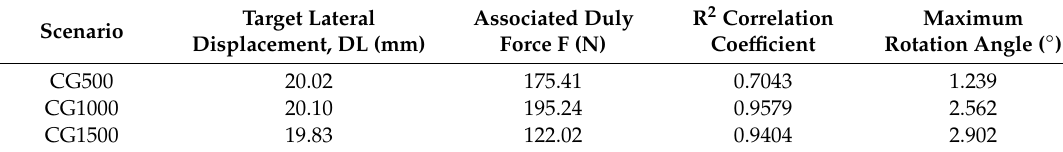
Table 3. Centralization of experimental results for CG